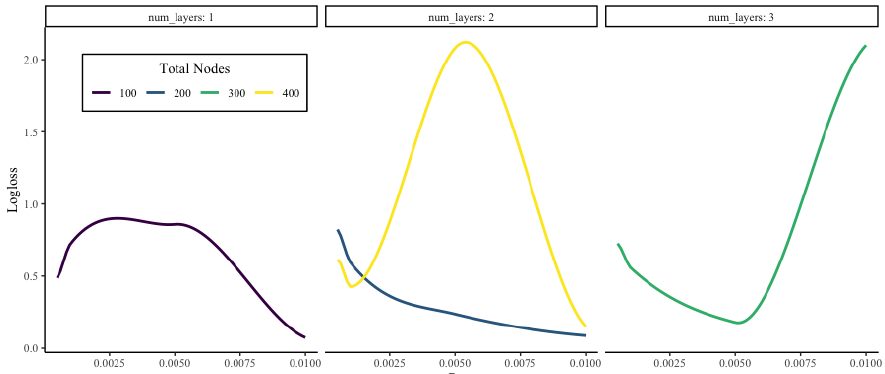
Figure 4. Visualization of the results from tuning deep learning models to predict claim frequency on the BI data. Here, we show the change in logloss across different values of learning rate for the deep neural network. The left pane shows the results when there is one layer, the middle pane shows results when there are two layers, and the right pane shows there are three layers. The coloring of the lines correspond to the total number of nodes in the neural